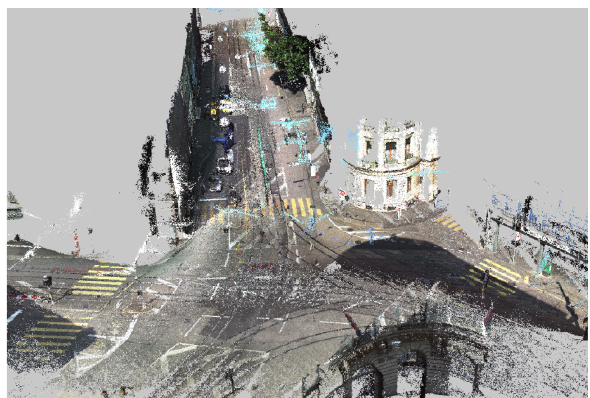
Figure 9. Filtered and fused point cloud exploiting one match image per base image (configuration 1)